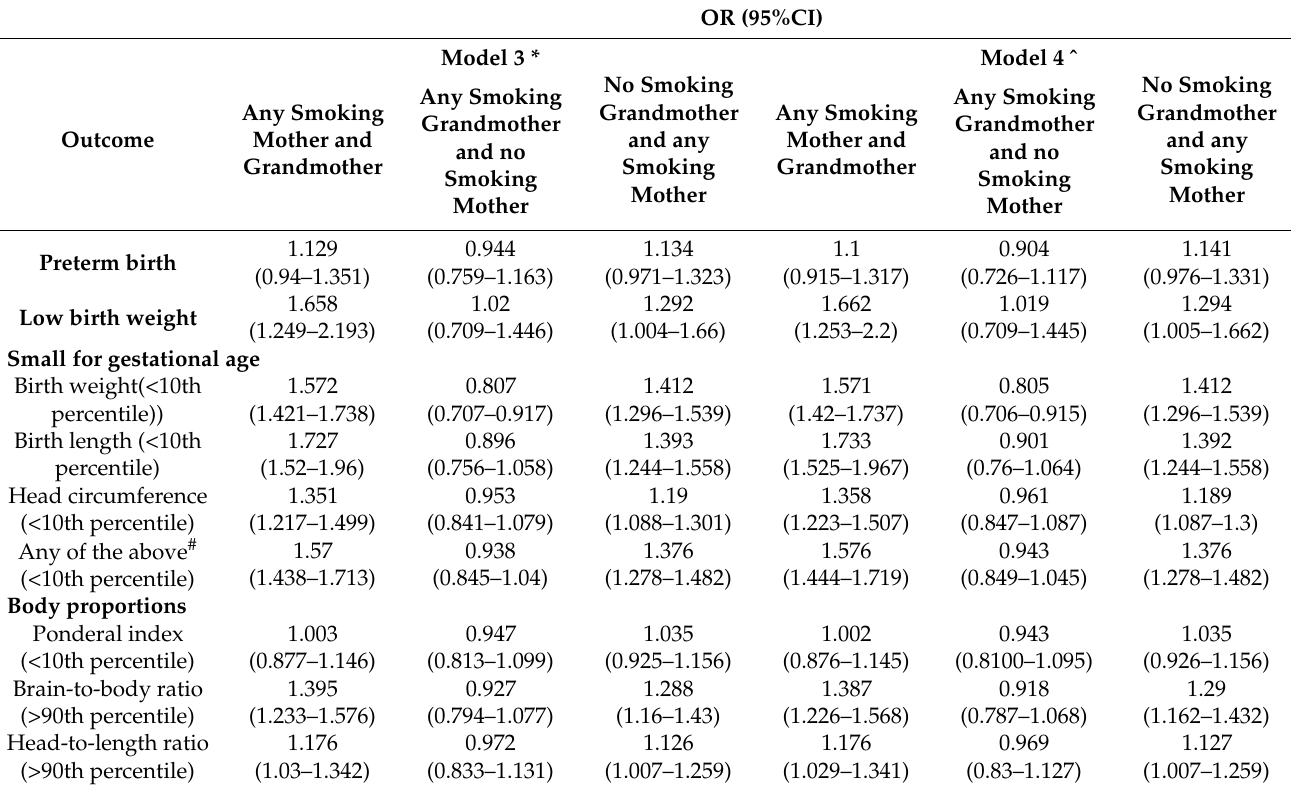
Table 5. Adjusted odds ratios for the effect of 2-generational smoking during pregnancy on birth outcomes in reference to no smoking during pregnancy of grandmother and